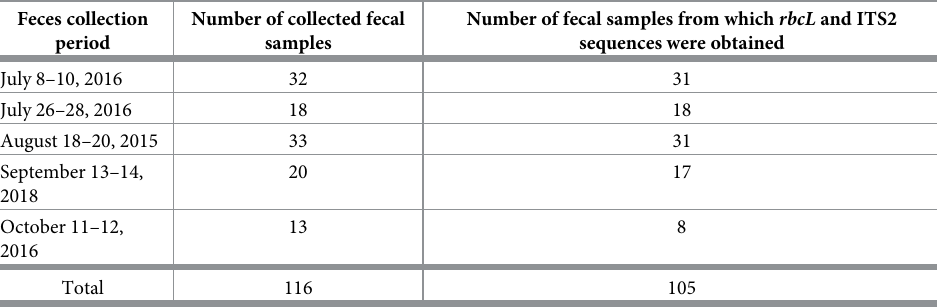
Table 1. List of dates when fecal samples were collected, number of fecal samples used in the experiment, and number of fecal samples that were successfully DNA metabarcoded. Feces collection